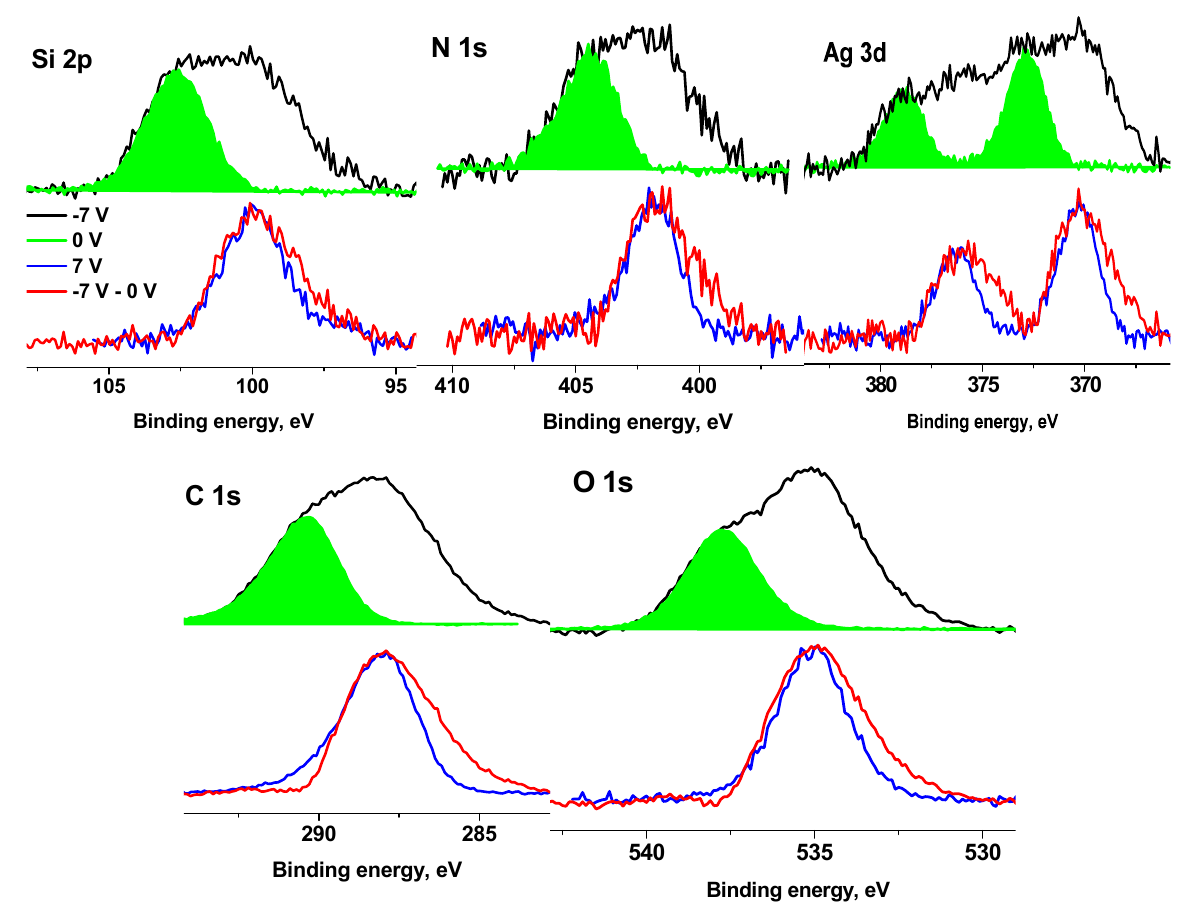
Figure 14. The XPS Si 2p, N 1s, Ag 3d, C 1s and O 1s spectra of the Ag NPs/HBPAPES sample measured at different U b .